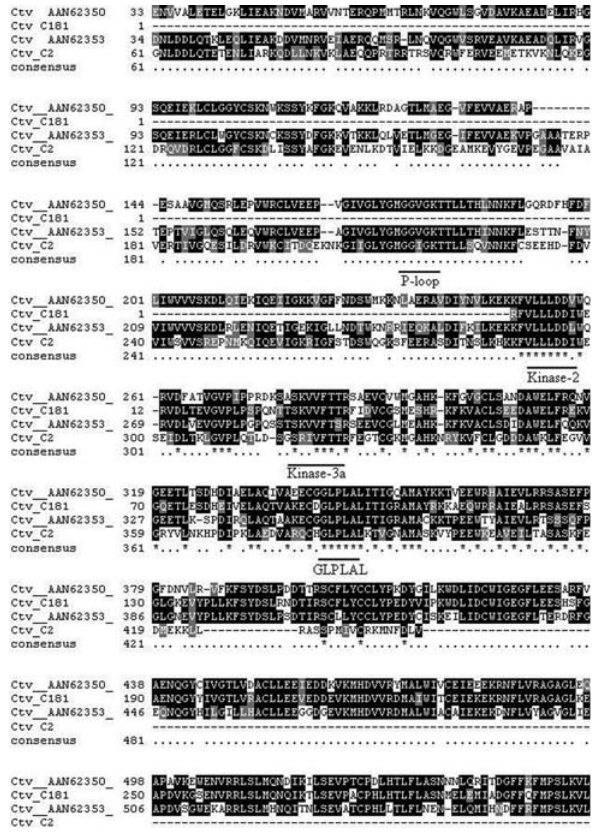
Figure 5 - Alignment (ClustalW) of the contigs C2 and C181 and Poncirus trifoliata Ctv proteins (GenBank Accession Numbers AAN62350 and AAN62353). Amino acids boxed in black and (*) are in- variant, whereas residues shaded in gray and (.) are conserved in > 75% of the sequences. Characteristic motifs are underlined.